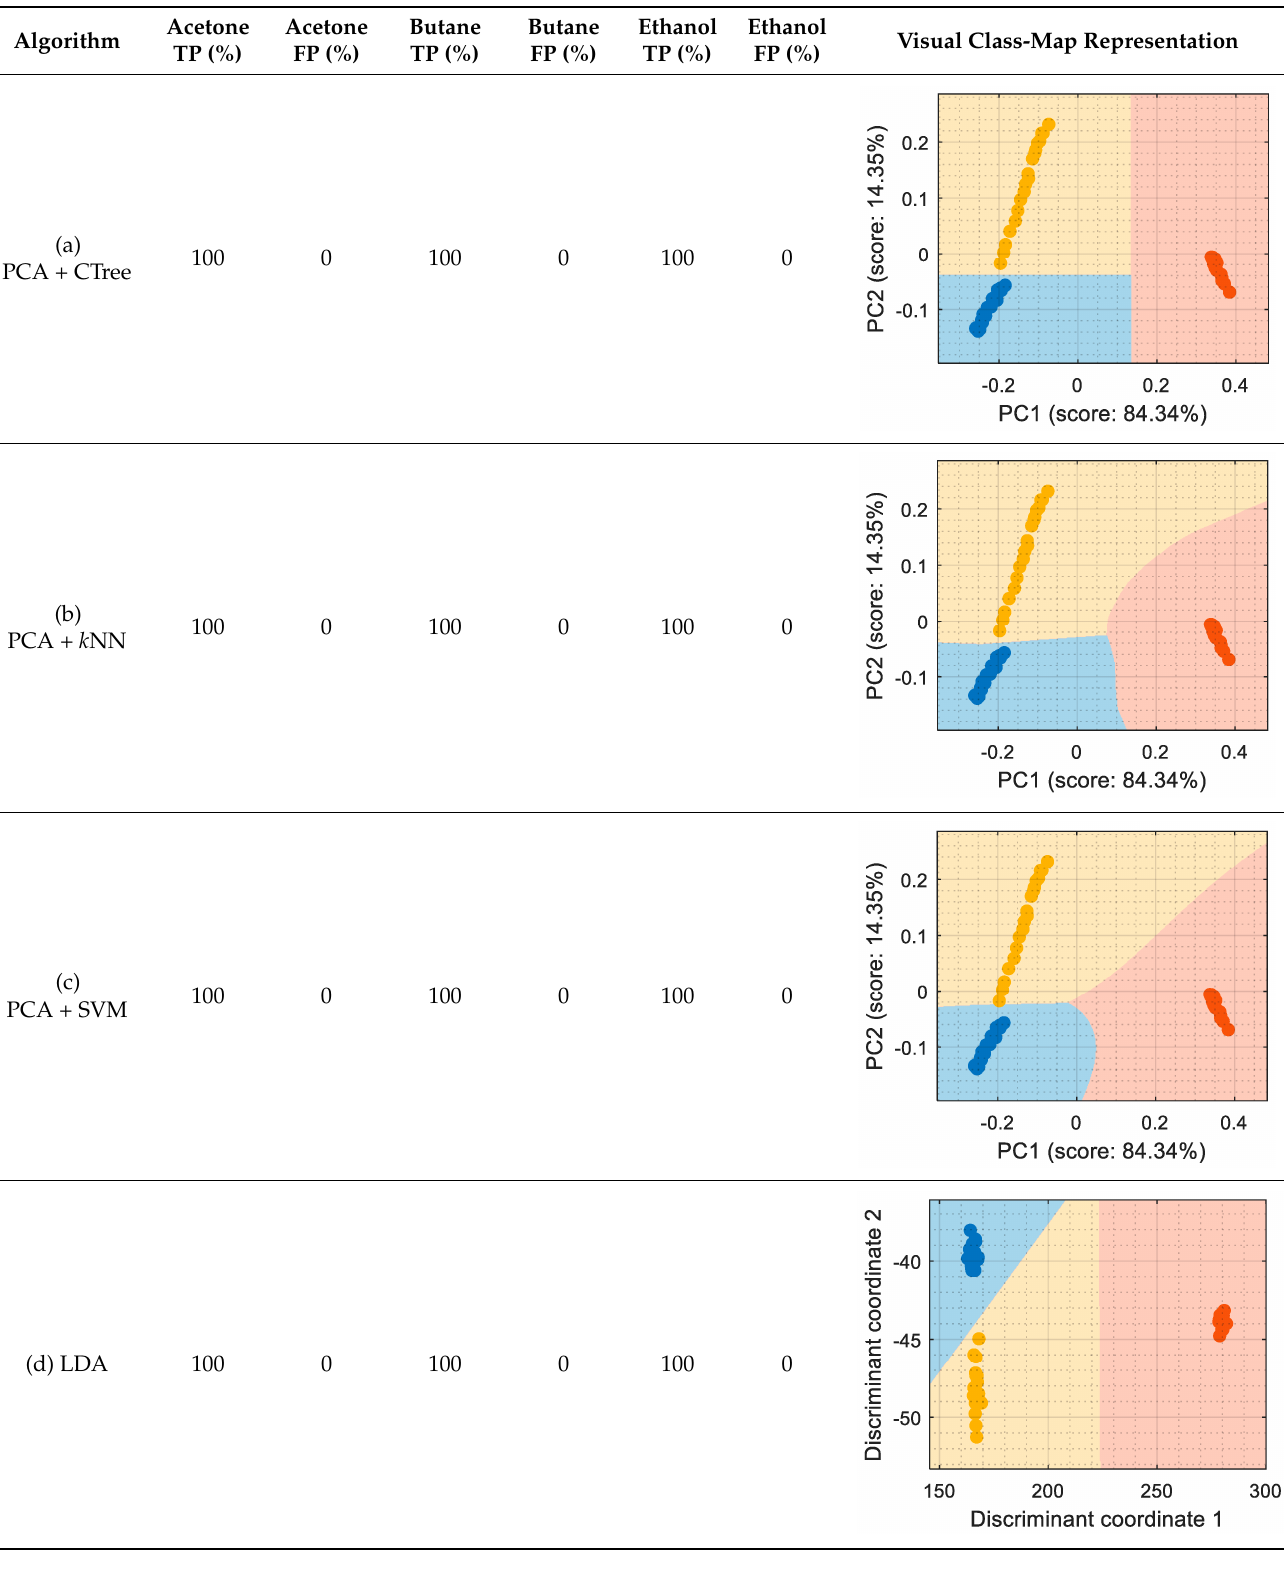
Table 4. Performance of the classifiers when processing the information gathered from the eNose as normalized conductance: representations of true positive (TP) and false positive